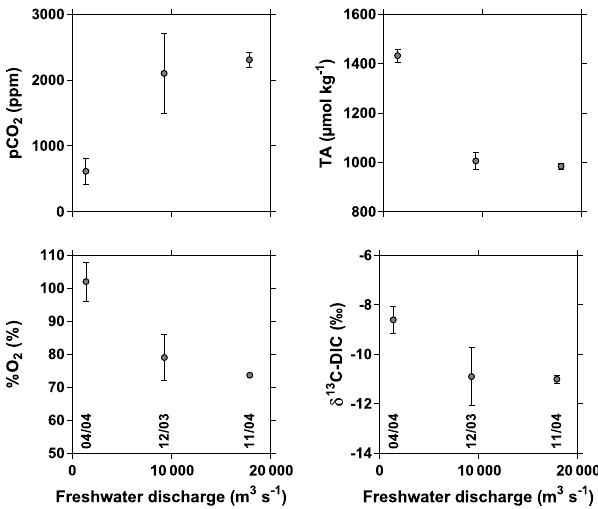
Figure 5. Variation as a function of freshwater discharge (m 3 s − 1 ) of the partial pressure of CO 2 (pCO 2 , ppm), oxygen saturation level (%O 2 , %), total alkalinity (TA, µmolkg − 1 ) , and stable isotope com- position of dissolved inorganic carbon ( δ 13 C-DIC, ‰) in the fresh- waters (salinity 0) of the three branches of the Mekong delta (M e y Tho, Hàm Luông, and C ´ˆ o Chiên) in December 2003, April 2004, and October 2004. Sampling dates (mm/yy) are indicated in the bot- tom